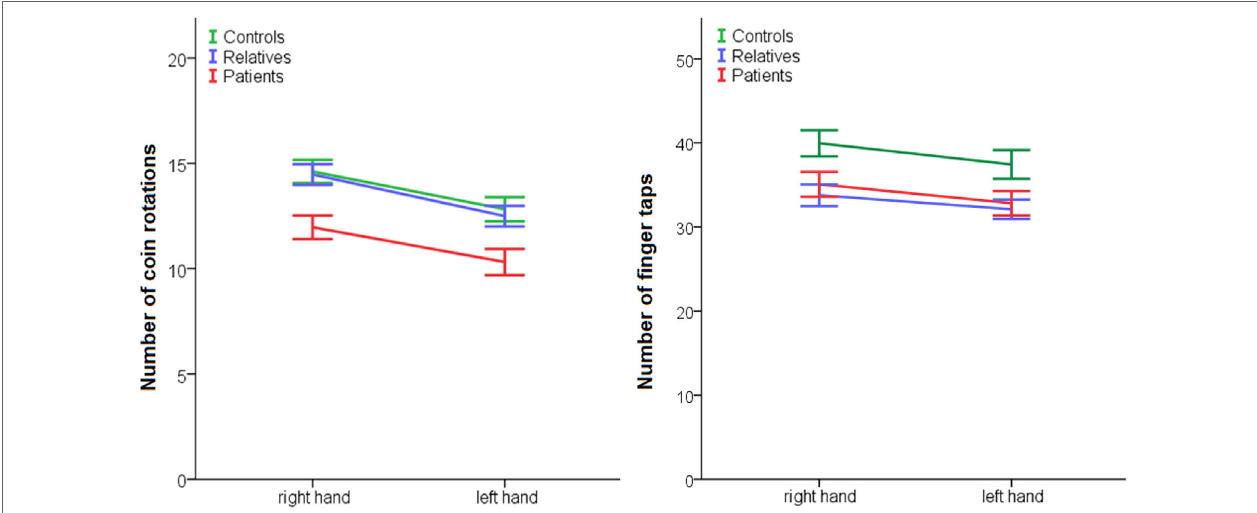
FigUre 2 | Performance of fine motor function in patients, relatives, and controls. Coin rotation: effect of group p = 0.001, effect of side p < 0.001, no effect